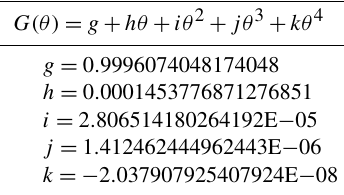
Table A2. Solar zenith angle function G(θ) used in Eq.